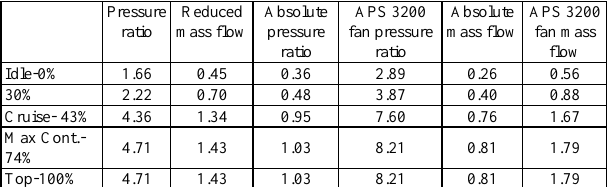
Table 16. Parameter of APS 3200 V = 0 Ma, H = 2000 m